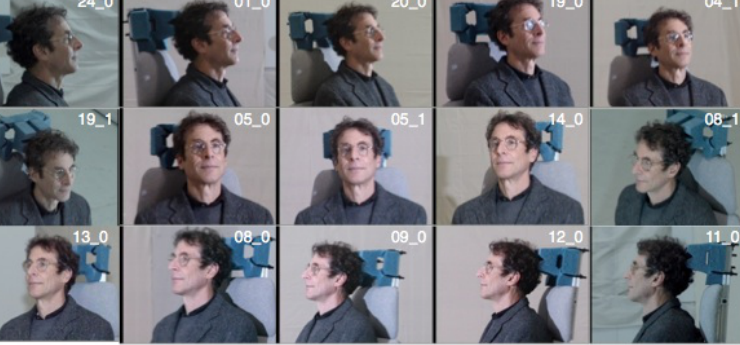
Figure 5. Example face images from the Multi-PIE database